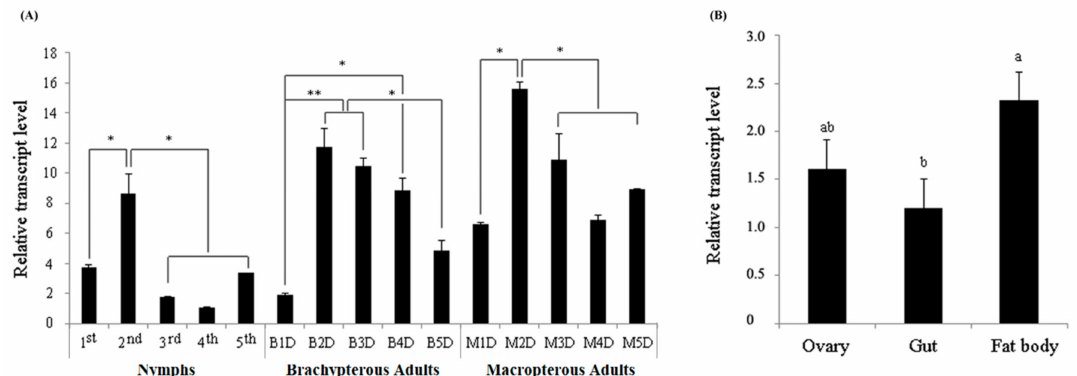
Figure 3. Expression patterns of NlITIH4 in different developmental stages and tissues. ( A ) Expression of NlITIH4 in different developmental stages, including 1st to 5th instar nymphs, one- to five-days old brachypterous adult females (B1D to B5D) and macropterous adult females (M1D to M5D). ( B ) Expression of NlITIH4 in ovary, gut, and fat body of female adults. Data are expressed as mean ± SE. Significant differences: * p < 0.05, ** p < 0.01. Different lower-case letters above the bars indicate significant differences for which p <